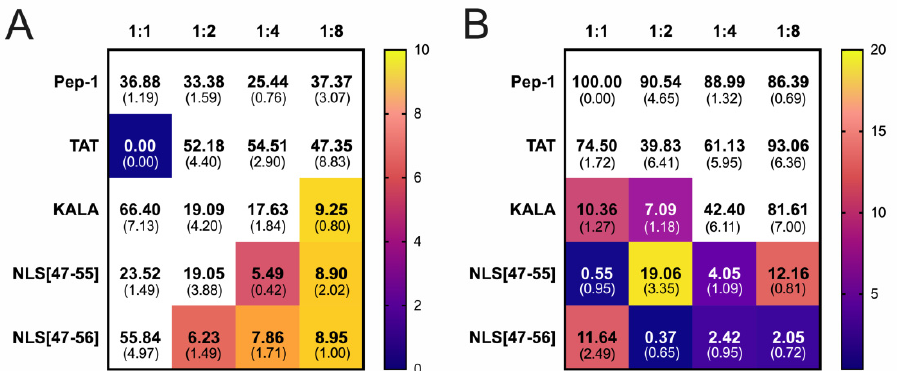
Figure 12. Results of 24 h culture in the presence of complexes in CRs of 1:1, 1:2, 1:4 and 1:8. The complexes were formed using incubation of 2 μ g pmaxGFP with chosen CPPs at 37 °C for 30 min. Bar = 50 μ m. CR, charge ratio.